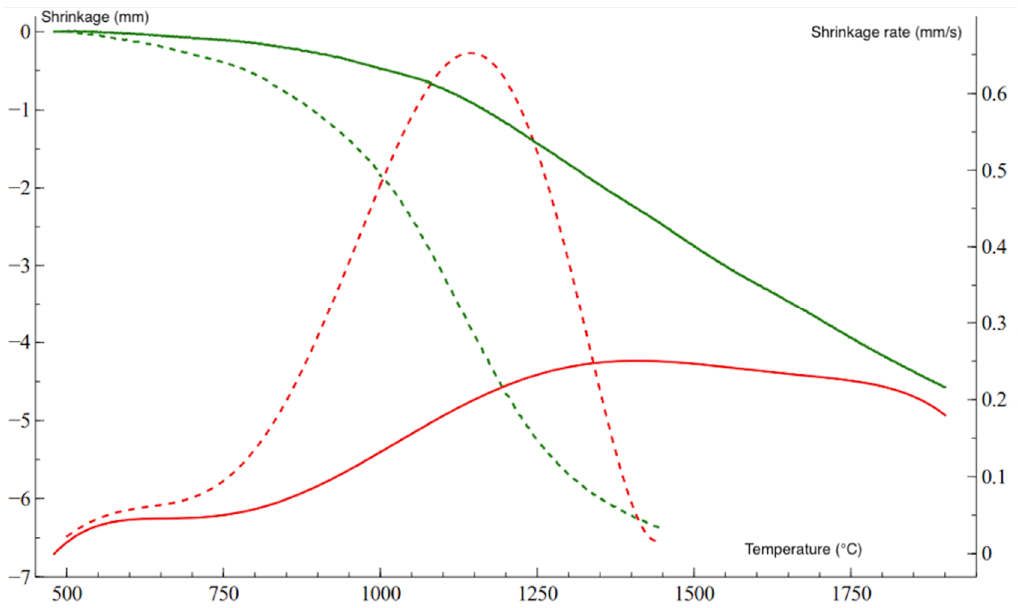
Figure 16. Shrinkage curves and densification speed for an unmilled Mo-45 powder (solid line, green shrinkage, red speed) and mechanically activated Mo powder (dotted line green shrinkage, speed in red). This figure clearly shows the advantage of milling to modify the sintering conditions of molybdenum powder.